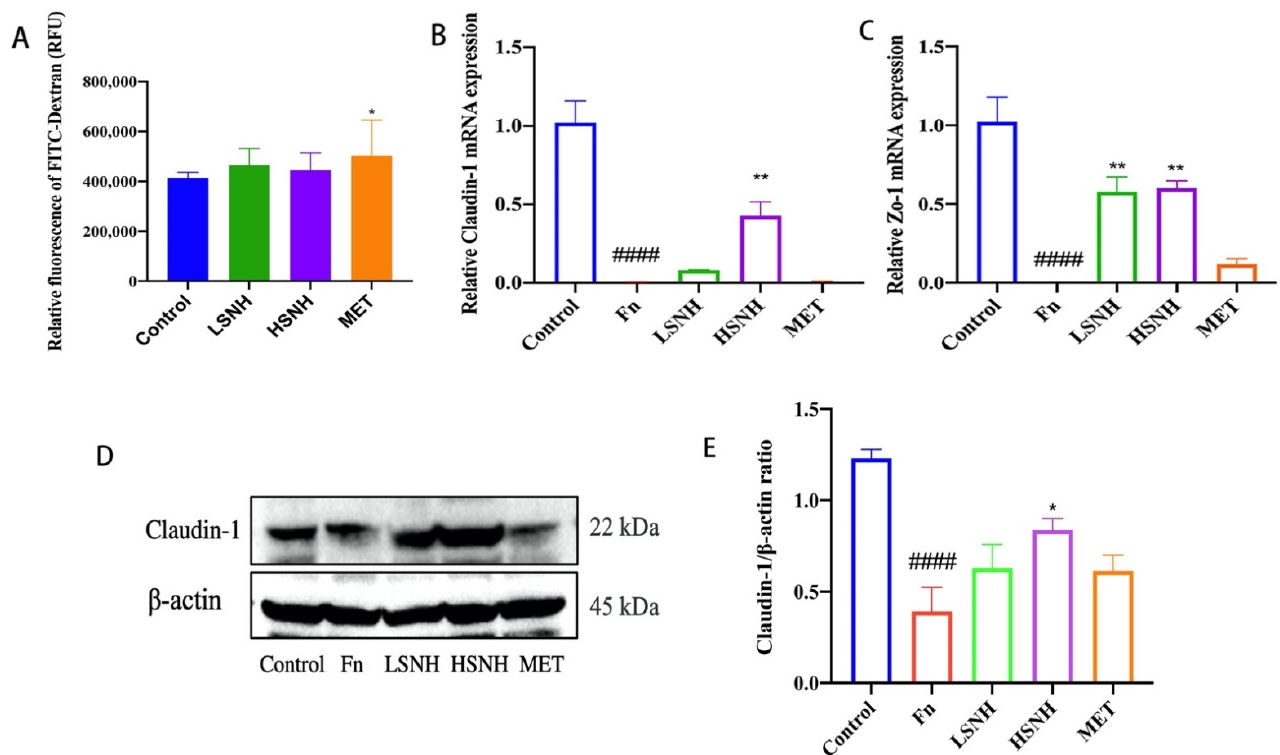
Figure 7. Effect of SNH on the integrity of intestinal barrier in HCT116-xenograft-bearing mice. ( A ) Effects of SNH and MET on the permeabilization of the intestinal barrier in the CRC cells-engrafted mice assessed by 4 kD FITC-Dextran permeability assay. Plasma was collected and measured the FITC-fluorescence intensity 4 h after the CRC-bearing mice were intragastrically gavaged with 4 kD FITC-Dextran. ( B , C ) qPCR analysis of the expression of genes encoding the tight junction proteins Claudin-1 ( B ) and Zo-1 ( C ) in the colon tissues from HCT116-engrafted mice with Fn colonization. ( D ) Immunoblot analysis of Claudin-1 in the colon tissues from different groups of mice engrafted with HCT116 cells. ( E ) The relative ratios of Claudin-1 to β -actin from D were quantitated . Data were expressed as mean ± SD, and p < 0.05 was considered statistically significant. * p < 0.05, ** p < 0.01, vs. Fn group. #### p < 0.0001, vs. Control.